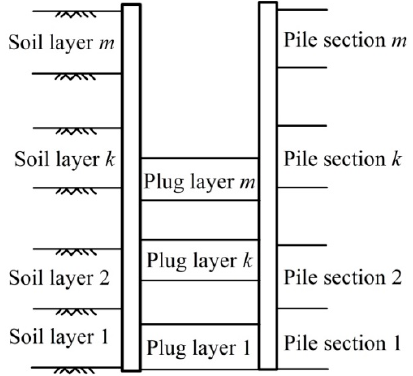
Figure 7. Computation diagram of the pipe pile in layered soils.